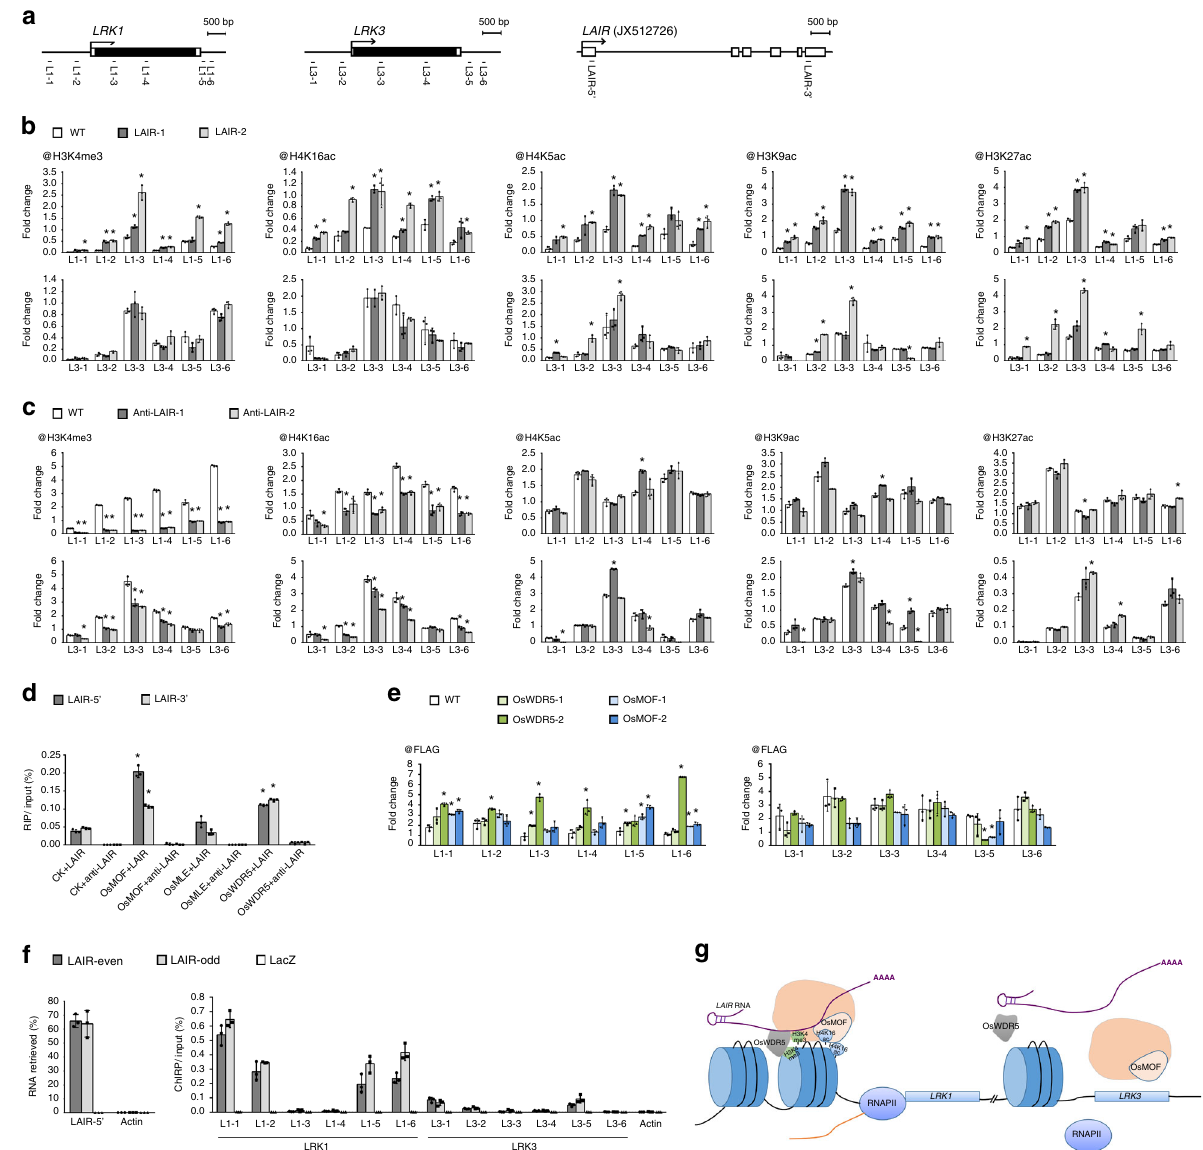
Fig. 4 Molecular processes involving LAIR RNA, epigenetic modi fi cation proteins and chromatin of LRK genes. a Schematic representation of LRK1 , LRK3 , and LAIR (JX512726) gene structure and primers position indicating the regions examined in the ChIP, RIP, and ChIRP assays of b – f . Black boxes indicate open reading frame. b , c ChIP assays of LRK loci. The ChIP analyses were completed for the LRK1 and LRK3 chromatin regions using antibodies against H3K4me3, H4K5ac, H3K9ac, H4K16ac, and H3K27ac in rice wild-type (WT) and LAIR -overexpressing (LAIR-1 and LAIR-2) lines ( b ) or antisense RNAi-